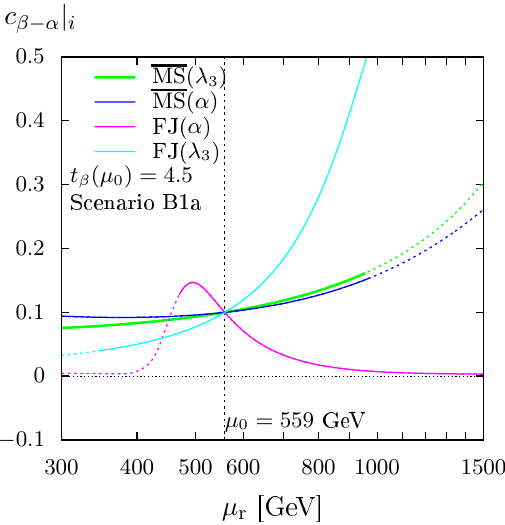
Figure 22 . The running of c (cid:12) (cid:0) (cid:11) for benchmark scenario B1a in the MS( (cid:11) ) (blue), MS( (cid:21) FJ( (cid:11) ) (pink), and FJ( (cid:21) 3 ) (turquoise) schemes. The breakdown of perturbativity ( (cid:21) max is indicated by changing the NLO curve to dotted lines.